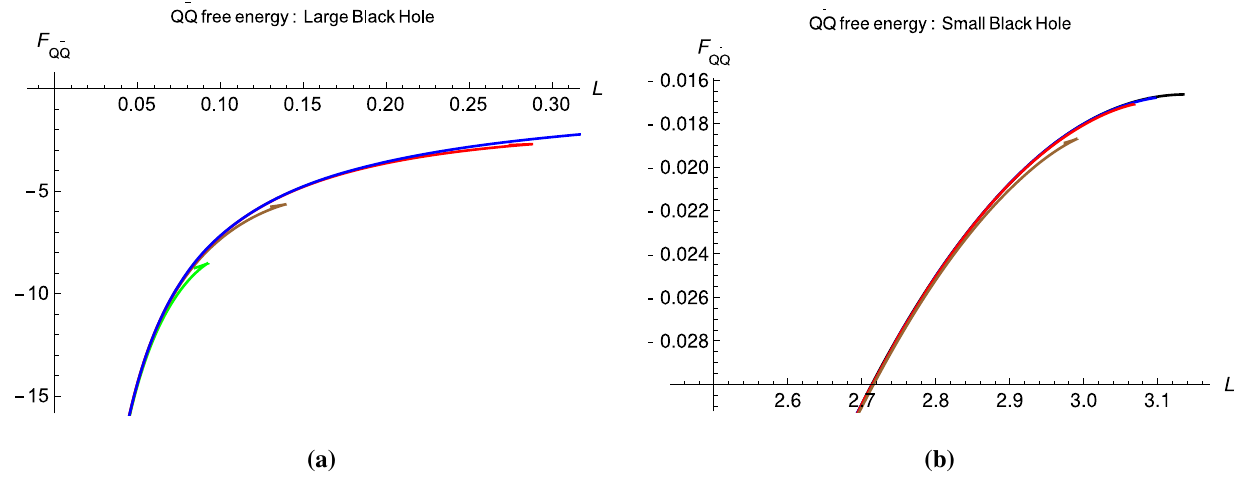
Fig. 12 ¯ a = . 05; Q ¯ Q free energy vs. L: a large black hole with T = 3 (green), 2 (brown), 1 (red), 0.5 (blue), b small black hole with T = 2 (brown), 1 (red), 0.5 (blue), .01